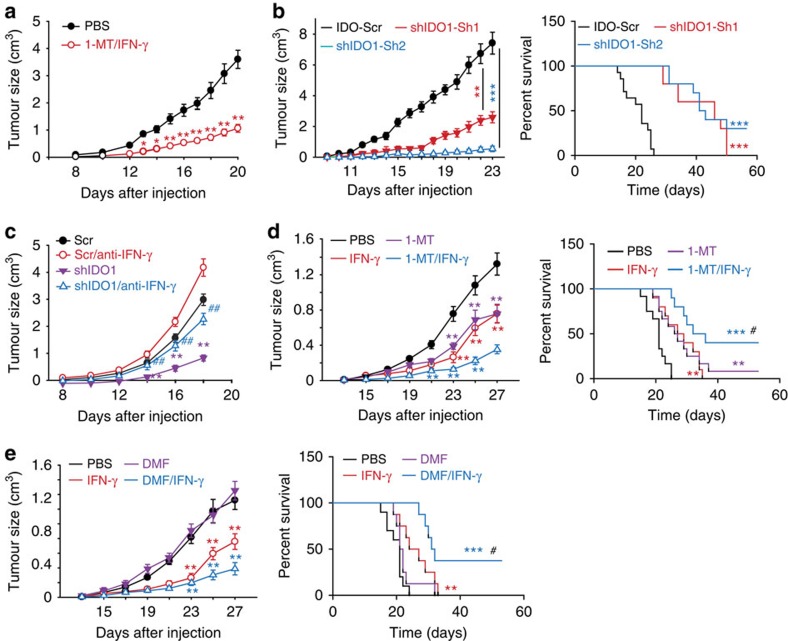
The combining therapy of IFN-γ and 1-MT/DMF targets tumour independent of the adaptive immune system.(a) The NOD-SCID mice (n=8) with B16 melanoma (7 × 7 mm) were treated with IFN-γ/1-MT for 1 week. The tumour growth was measured. (b) IDO1-stably silencing or scramble control B16 cells (1 × 105) were s.c. injected to C57BL/6 mice (n=10 per group). The tumour growth was measured (left) and long-term survival was analysed (right). (c) IDO1-knockdown or scramble control B16 cells were injected to C57BL/6 mice (n=8 per group). Twelve hours before tumour cell injection, mice were treated with anti-IFN-γ antibody (250 μg) once every 2 days. Tumour growth was measured. (d) C57BL/6 mice (n=10 per group) were s.c. injected with 1 × 105 B16 cells. Three days later, mice were treated with IFN-γ (intratumoral injection of 20 μg per day, once every 2 days), 1-MT (5 mg ml−1 in drinking water, 3–4 ml per mouse per day) or IFN-γ/1-MT for 10 days. The tumour growth was measured (left) and long-term survival was analysed (right). (e) Three days after injection of 1 × 105 B16 cells, C57BL/6 mice were treated with IFN-γ, DMF (intragastric injection of 10 mg kg−1, once per 2 days) or IFN-γ/DMF for 10 days (n=10 per group). The tumour growth was measured (left) and long-term survival was analysed (right). The data represent mean±s.e.m., *P<0.05, **P<0.01, ***P<0.001 versus PBS group; #P<0.05, ##P<0.01 versus Scr or IFN-γ group (Student's t-test or Kaplan–Meier analysis).